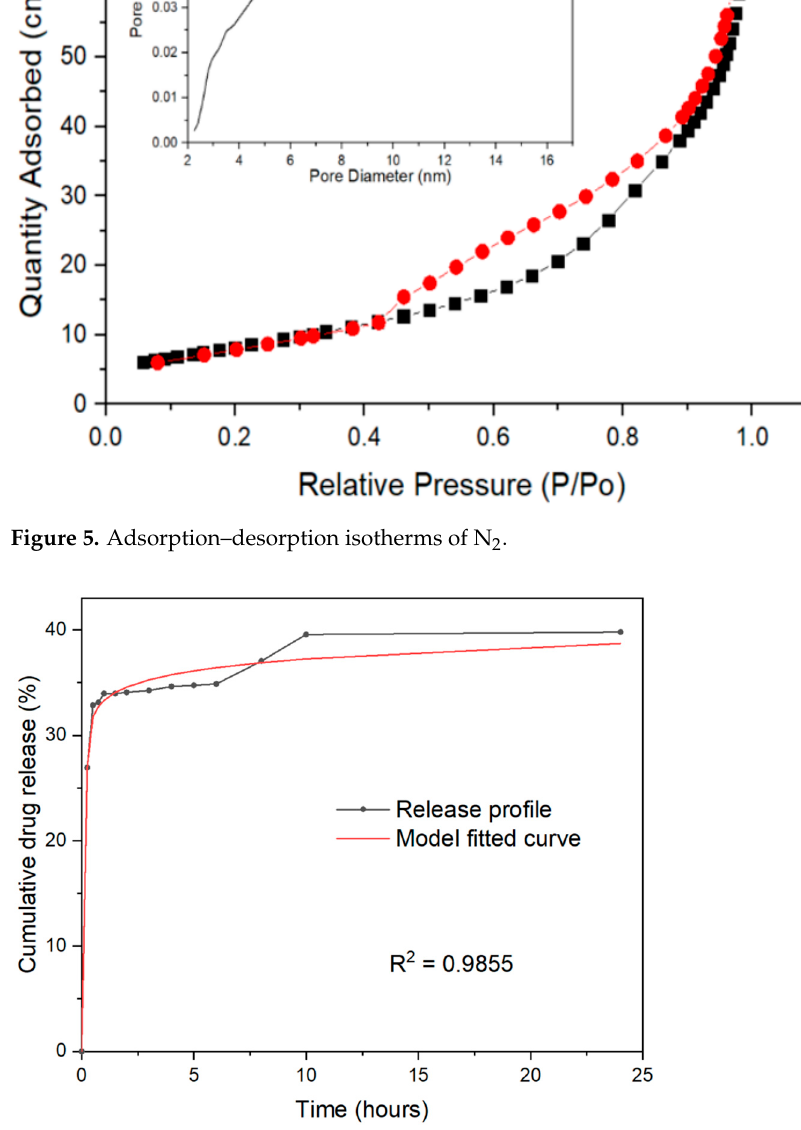
Figure 6. Profile of drug delivery of nanomaterials PLGA–TiO 2.